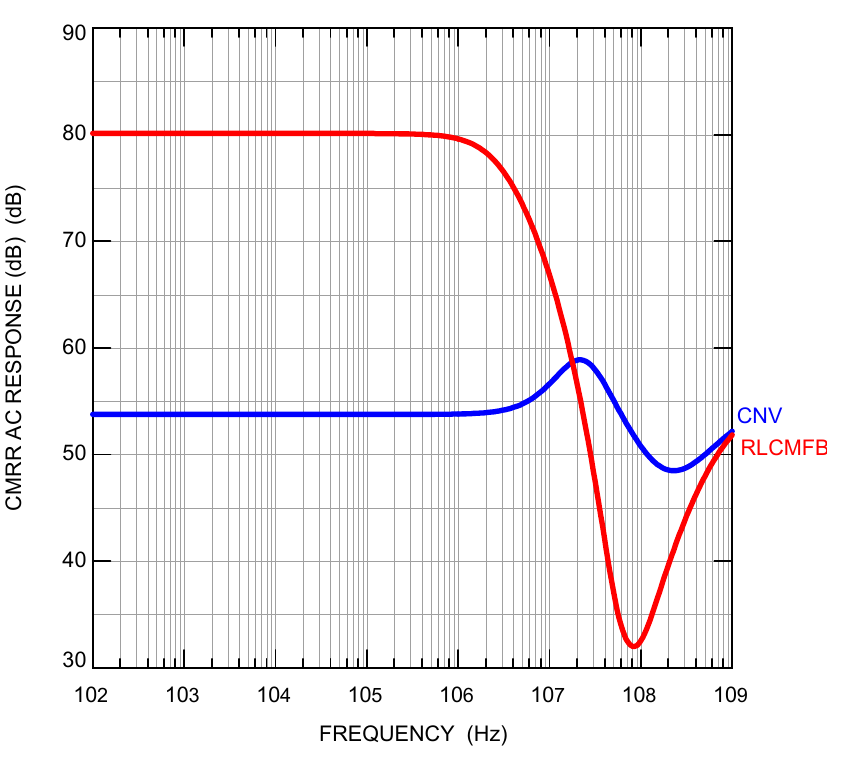
Figure 6. Transient response of circuits of Figure 3. Top: input and output voltages, bottom: output currents.